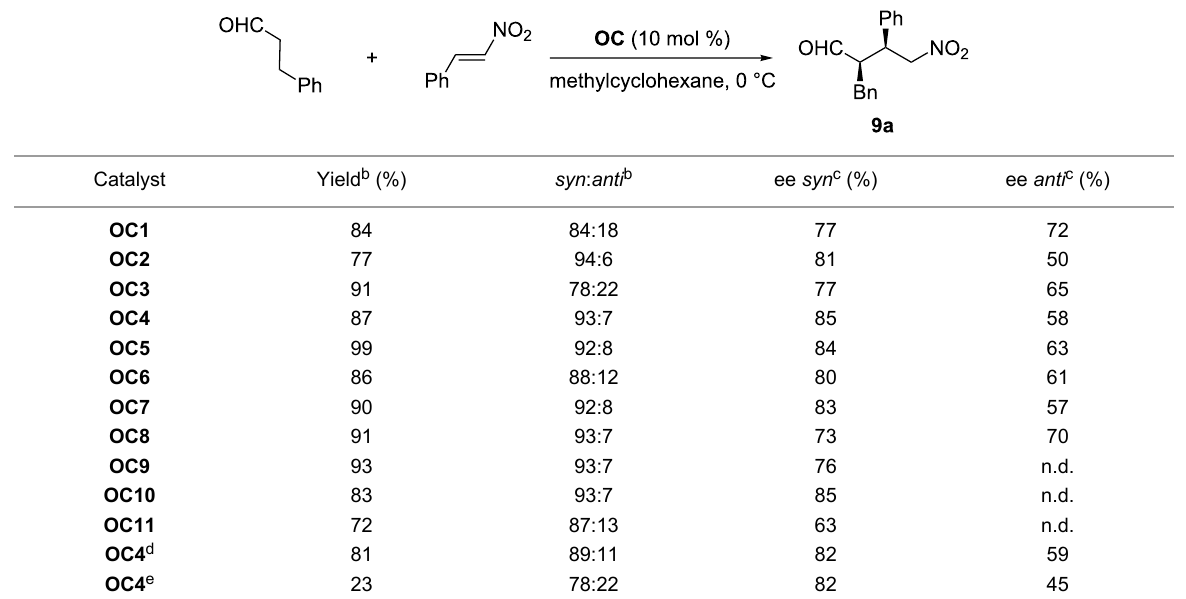
Table 3: Screening of organocatalysts OC1 – OC11 for the Michael addition of 3-phenylpropionaldehyde to trans - β -nitrostyrene. a